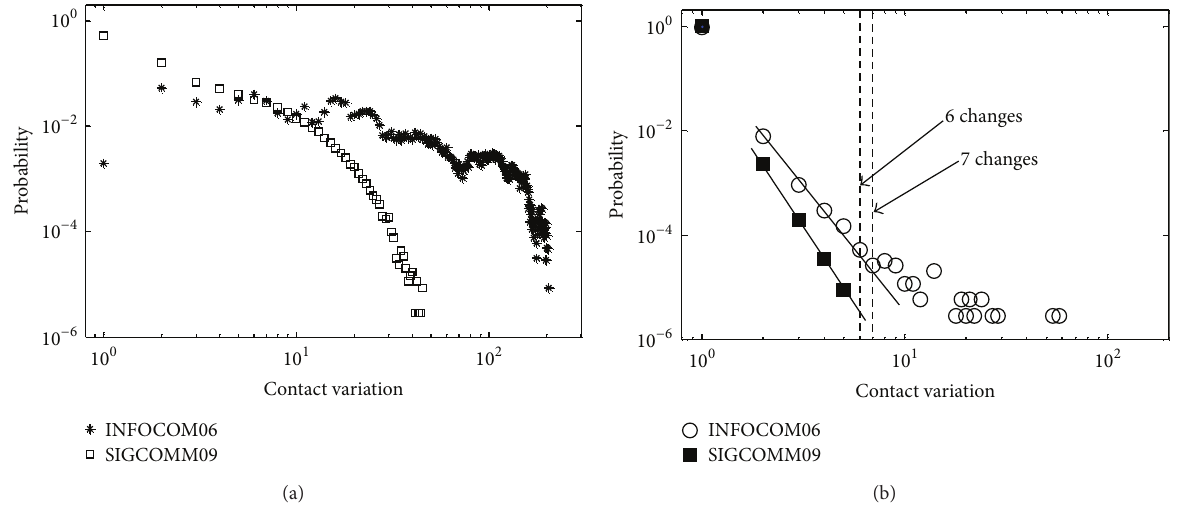
Figure 1: (a) Distribution of history contact duration. (b) Distribution of CCSC.